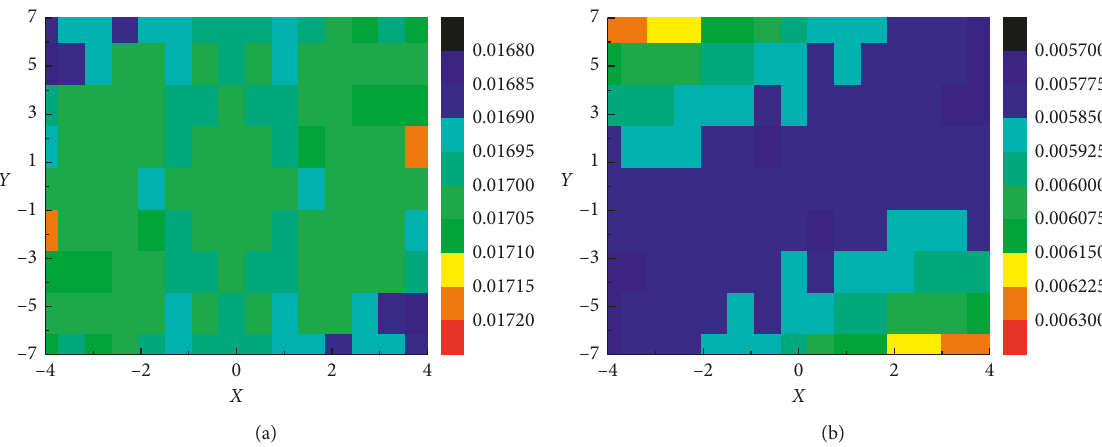
Figure 7: System response under bidirectional ground motion when mass center and stiffness of primary structure are coincident. (a) Displacement variance of the X direction of primary structure. (b) Displacement variance of the X direction of secondary structure.